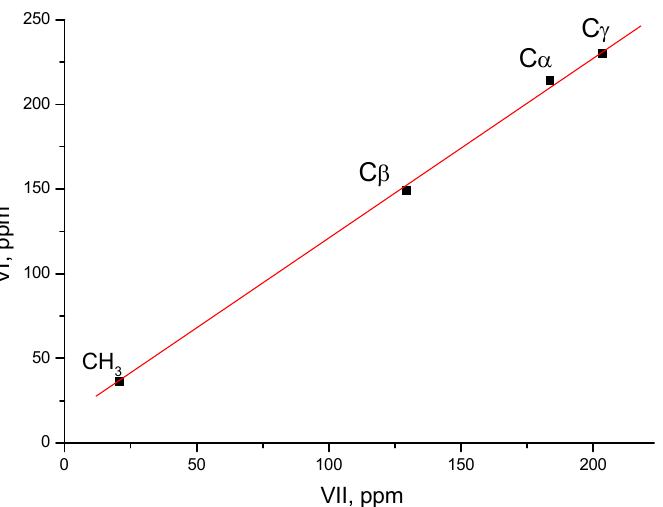
Figure 11. Correlation between chemical shifts of interpreted signals of 13 C NMR of the cation VII and those of the cation VI. Table 5. Chemical shifts δ * in the MAS NMR spectra of isomer VI in its C 4 H 5+ {Cl 11 − } salt.